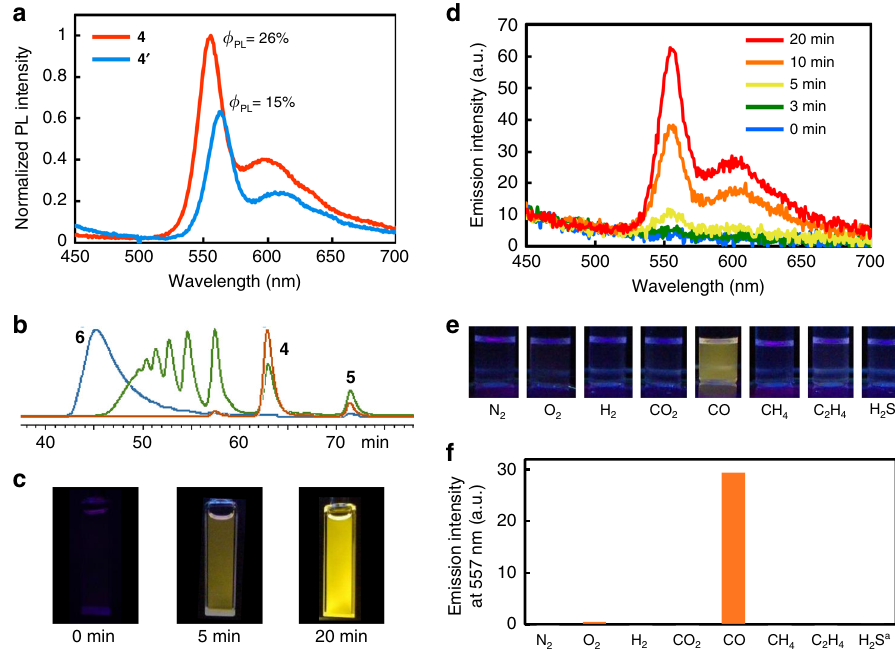
Fig. 3 Optical analyses of Pt complexes and bimetallopolymer. a Emission spectra of Pt complexes 4 and 4 ʹ in deoxygenated toluene (concentration: 10 − 5 M). The spectra were corrected to the same number of photons absorbed at the excitation wavelength. b SEC pro fi les at various time points (blue: 0 min, green: 5 min, and orange: 20 min). c Photographic images upon excitation at 365 nm, and d emission spectra at a concentration of 10 − 2 mg/mL in deoxygenated toluene under excitation at 365 nm after depolymerization of the bimetallopolymer 6 with CO gas at various time points. e Photographic images and f emission intensities under deoxygenated conditions after depolymerization of the bimetallopolymer 6 with various gases under UV irradiation. a 1% (v/v) H 2 S was present in the N 2